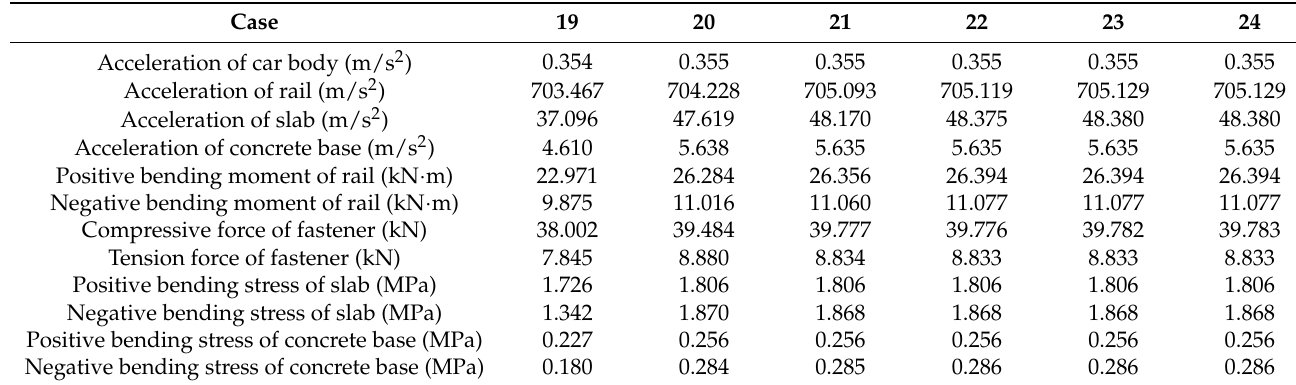
Table 8. Largest dynamic responses for Cases 19–24.